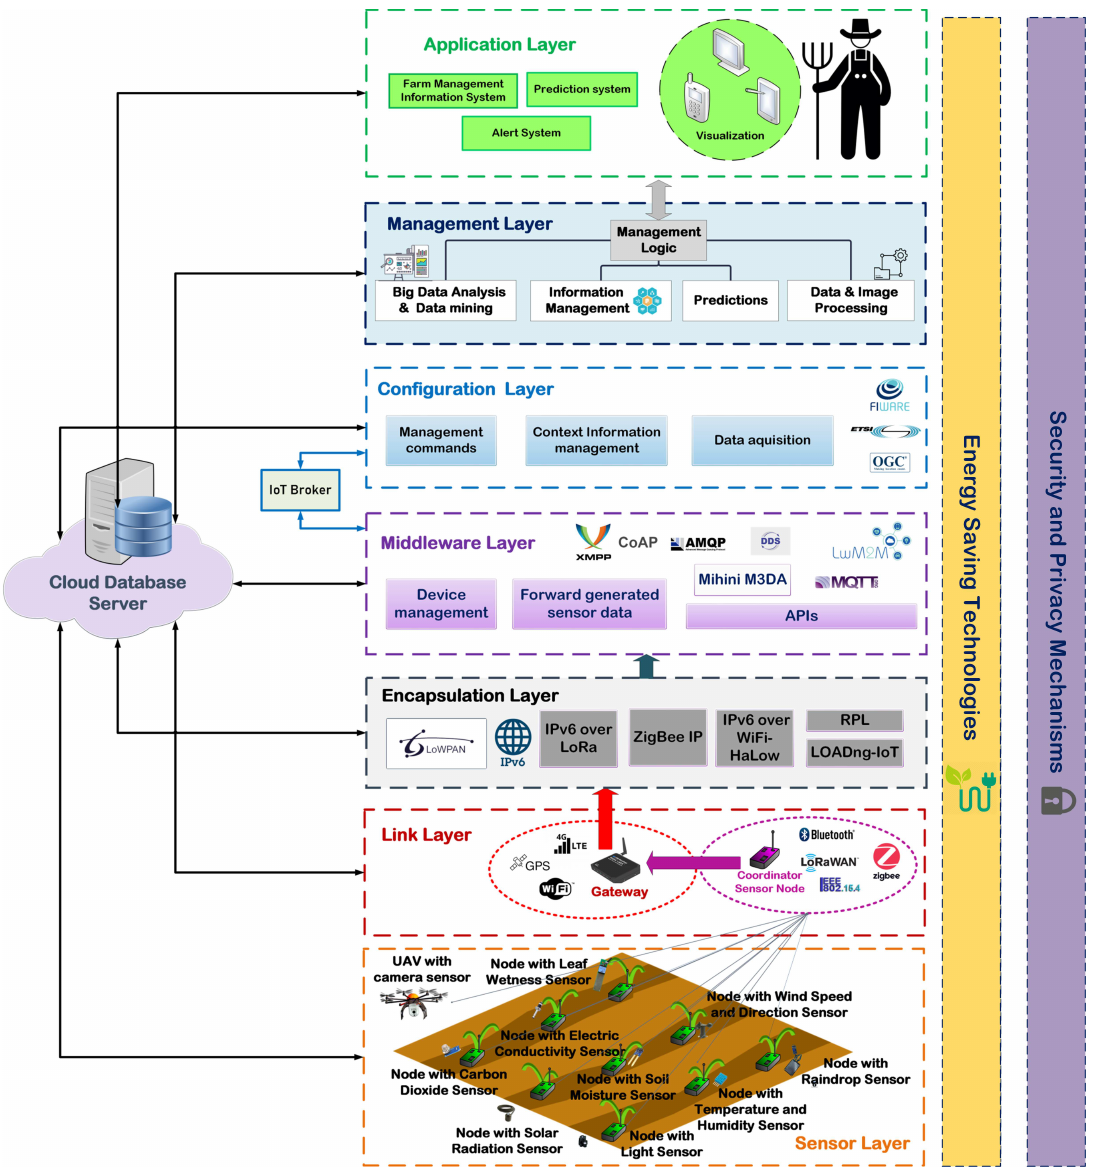
Figure 1. Remote Sensing System